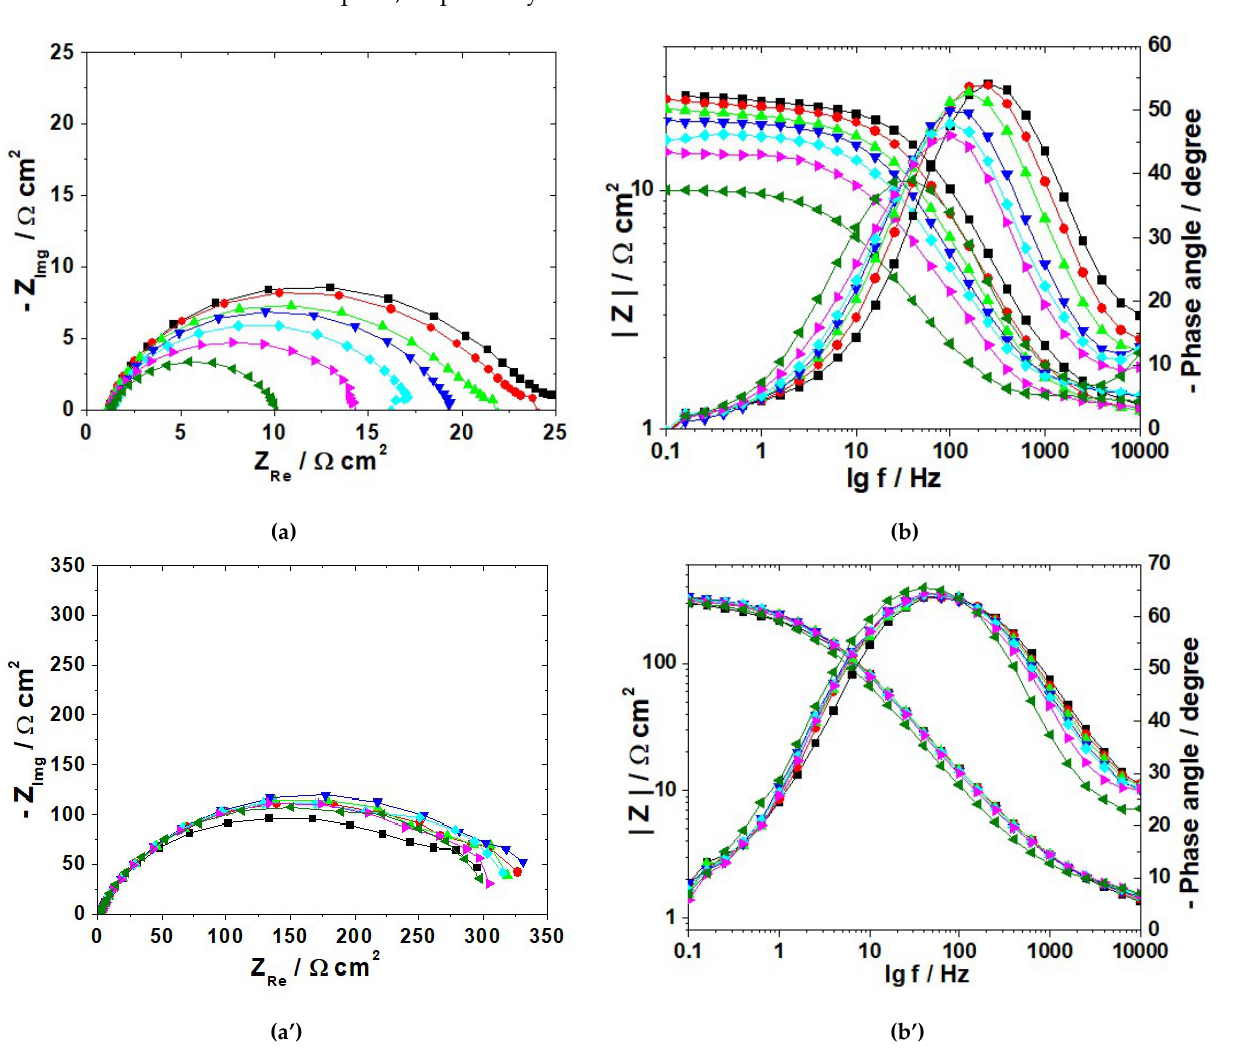
Figure 5. Nyquist and Bode plots of C-steel samples in 1.0 M HCl solution in the absence ( a,b ) and in the presence of 5 mM PyODT ( a’,b’ ). The spectra were recorded at different immersion times in the test solutions (hours): ( ■ ) 2; (●) 4; ( ▲ ) 6; ( ▼ ) 8; ( ♦ ) 10; ( ► ) 12; ( ◄ ) 24.